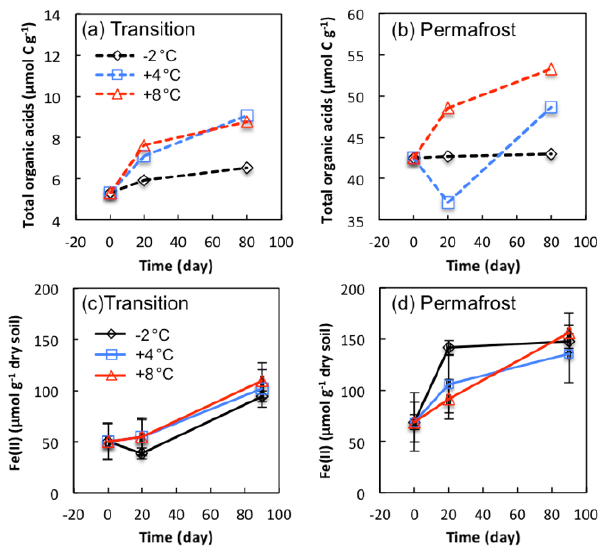
Figure 7. Changes in total organic acids carbon (a, b) and Fe(II) concentrations (c, d) in soils from transition layer and permafrost of FCP during anoxic incubations. Total organic acids (µmolCg − 1 ) were calculated from the concentrations of individual organic acids (Table S5). Error bars for Fe(II) concentrations are ± 1 standard de- viation from three replicate